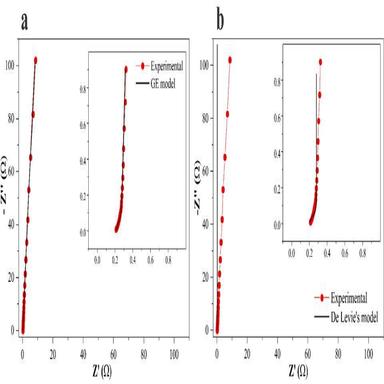
Complex-plane plots obtaind for the TMO-2 electrode and the CNLS simulations using the GE with CPEs (a) and De Levie's (b) models. Electrolyte: 1.0 M H2SO4 at 25 ◦C.